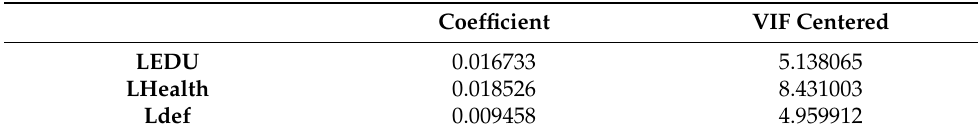
Table 7. VIF Results.